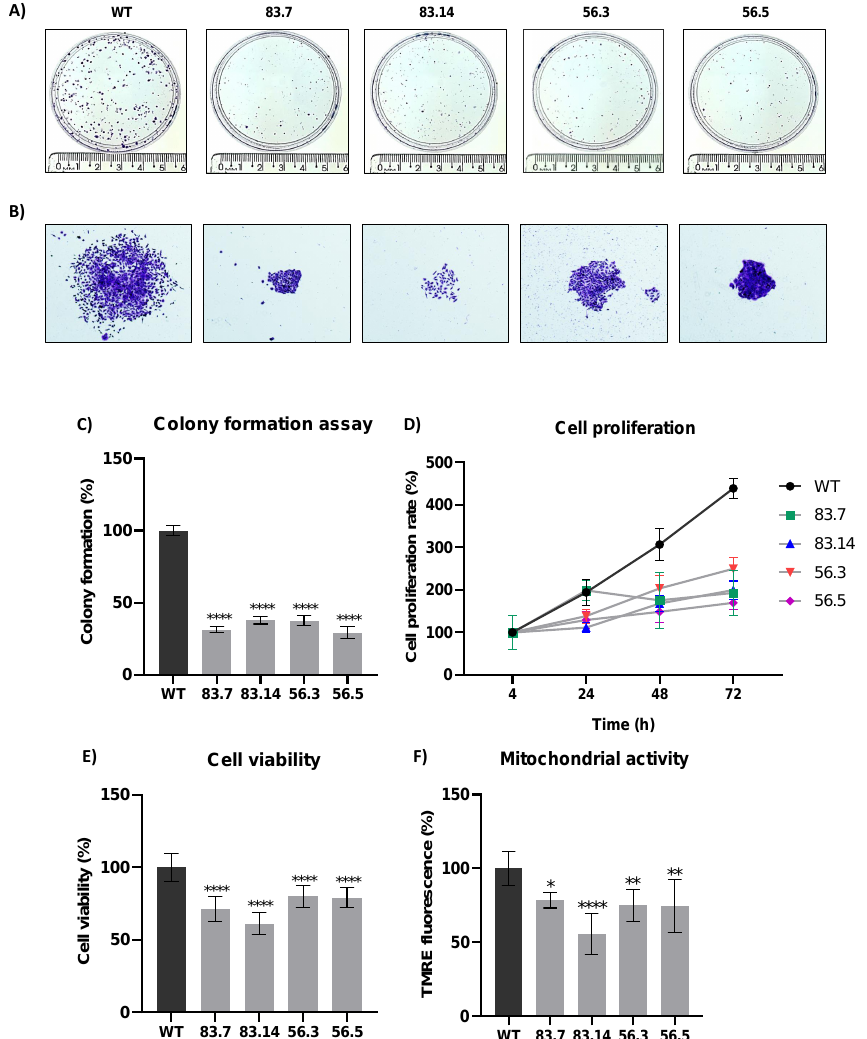
Figure 2. NEK6-KO reduces clonogenic capacity, cell proliferation, and mitochondrial membrane potential in DU-145 cells. ( A ) Deletion of the NEK6 gene significantly reduces the clonogenic potential in DU-145 cells. ( B ) Demonstrative images reveal the visual difference in colony size and its spread. ( C ) Quantification of colonies numbers obtained in WT and NEK6-KO cells. ( D ) Cells were evaluated for proliferation at 4, 24, 48, and 72 h after seeding, and the results showed all NEK6-KO clones significantly proliferated less than WT cells at 48 and 72 h. ( E ) Cells were maintained in an incubator (3 days) until reaching confluency. The MTT assay was performed to evaluate the viability of these cells. NEK6-KO showed a reduction in cell viability when compared to WT cells. ( F ) The target deletion of NEK6 in DU-145 cells also reduced the mitochondrial membrane potential using TMRE staining. * p < 0.05, ** p < 0.01 and **** p <